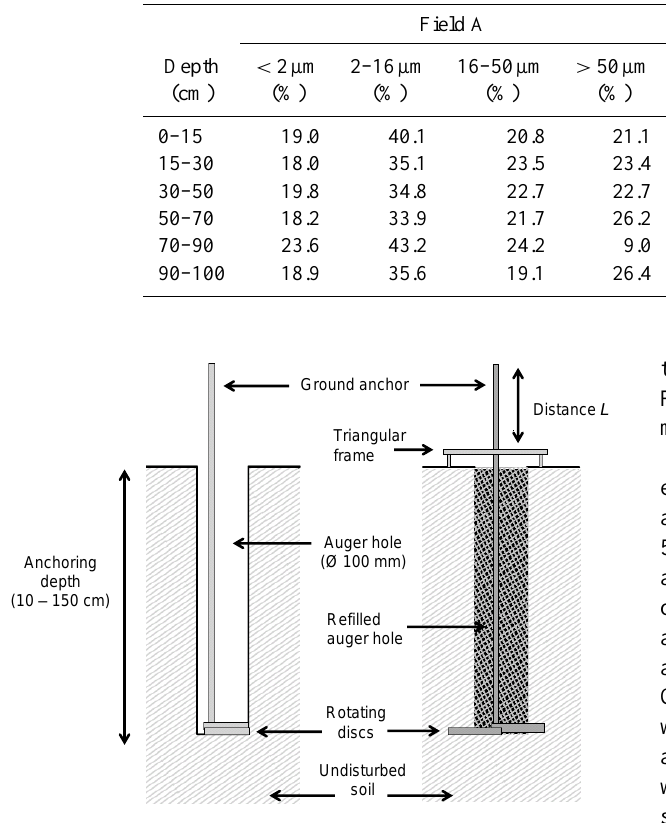
Fig. 3. Side view of the placement of ground anchors in the soil. Left: ground anchor lowered in auger hole. Right: ground anchor in refilled auger hole, with discs fixed in undisturbed soil after rotating the rod, and a metal frame placed over the